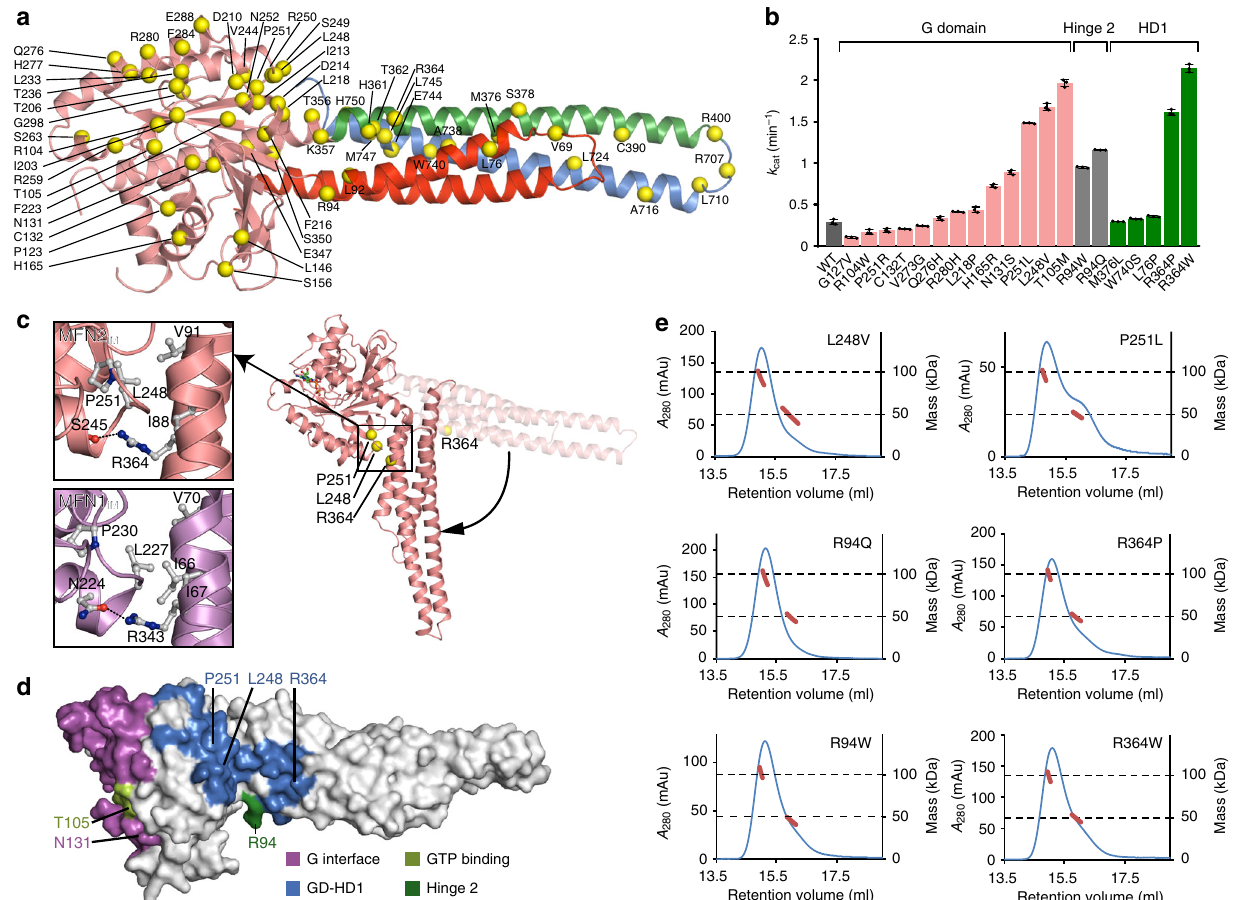
Fig. 6 Characterization of CMT2A-related mutants. a Overview of the CMT2A-mutation sites on MFN2. The CMT2A-related single-point mutation sites are speci fi ed as yellow spheres on MFN2 IM structure colored as in Fig. 1b. b GTP turnover rates of selected CMT2A-related MFN2 IM mutants in comparison with wild-type MFN2 IM . Locations of these mutants are color-speci fi ed. c CMT2A-mutation sites on the putative G domain-HD1 contact of MFN2 in the transition state. The structural model of rearranged MFN2 IM is generated base on the MFN1 IM - GDP (cid:1) BeF (cid:3) CMT2A-related residues and their potential interaction partners are presented as ball-and-stick models. d Functional zones of MFN2 and the involved CMT2A-mutation sites. e Dimerization property of CMT2A-mutants on the putative G domain-HD1 interface in the presence of GDP (cid:1) BeF (cid:3) are provided as a Source Data fi